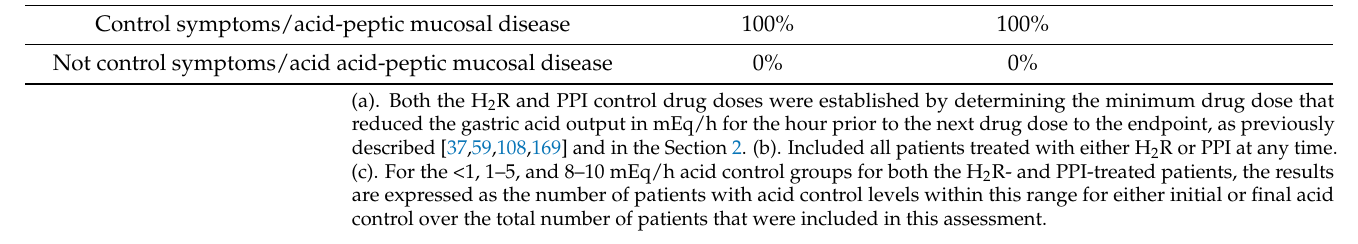
Table 7. Predictive value of various clinical, laboratory, tumor, or acid features for identifying patients requiring at least one dose change during PPI treatment between the first and final doses